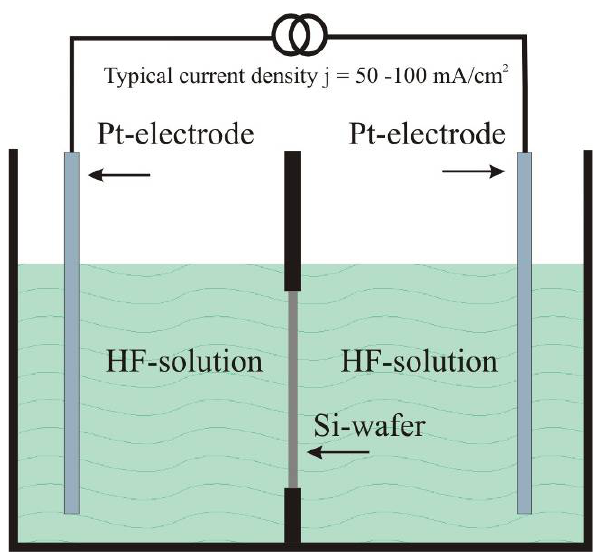
Figure 13. Scheme of a electrolytic double-tank cell to fabricate double-sided porous silicon samples. During the anodization process which is performed under pulsed conditions each side is contacted by the electrolyte. A typically used frequency is 0.1 Hz.